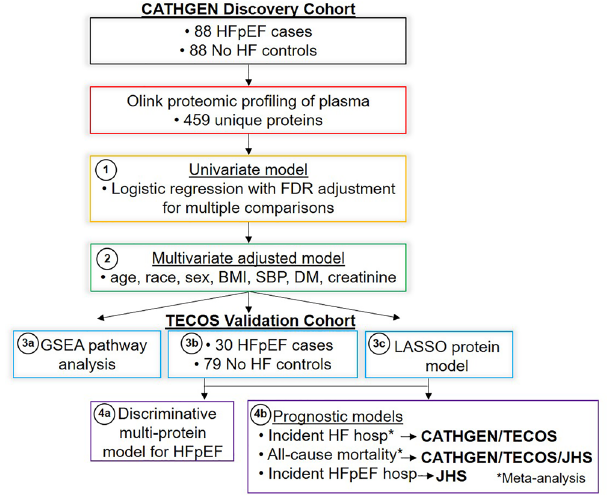
Figure 1. Methodologic approach to analysis of HFpEF-associated proteins. In step 1 univariate models with FDR adjustment were used to test associations between individual Olink proteins and HFpEF cases and non-HF controls in the CATHGEN discovery cohort. In step 2, significant proteins were tested in a multivariate adjusted model. In step 3, GSEA, validation in the TECOS cohort and LASSO were used to determine relevant HFpEF-associated proteins. In step 4, discriminative capabilities of multi-protein models were tested, as well as prognostic models for clinical outcomes. Abbreviations: Body Mass Index (BMI), Diabetes Mellitus (DM), False Discovery Rate (FDR), Gene Set Enrichment Analysis (GSEA), Heart Failure (HF), Heart Failure with Preserved Ejection Fraction (HFpEF), Hospitalization (hosp), Jackson Heart Study (JHS) , Systolic Blood Pressure (SBP), Trial Evaluating Cardiovascular Outcomes with Sitagliptin